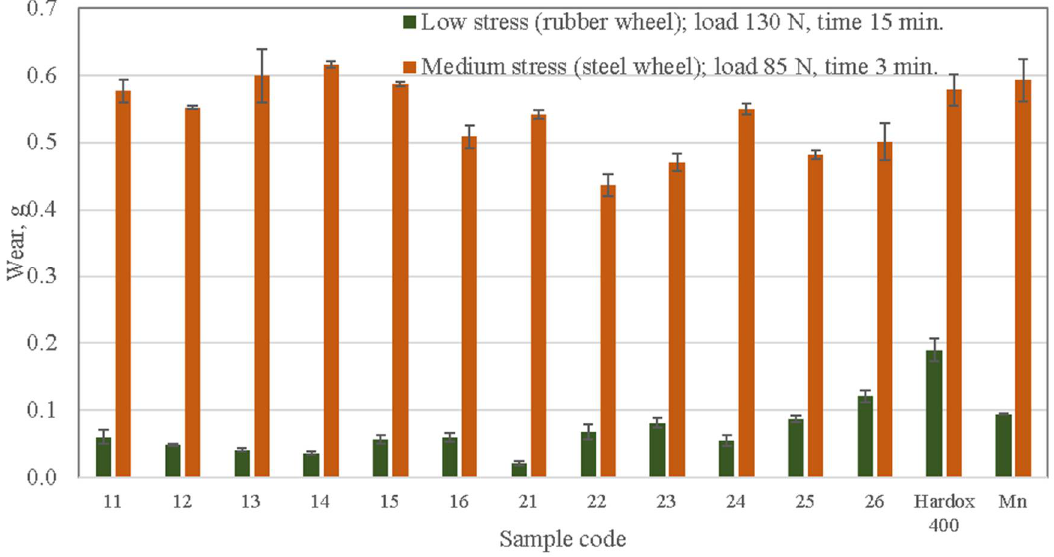
Figure 5. Wear rate of tested materials during low- and medium-stress abrasive wear test.